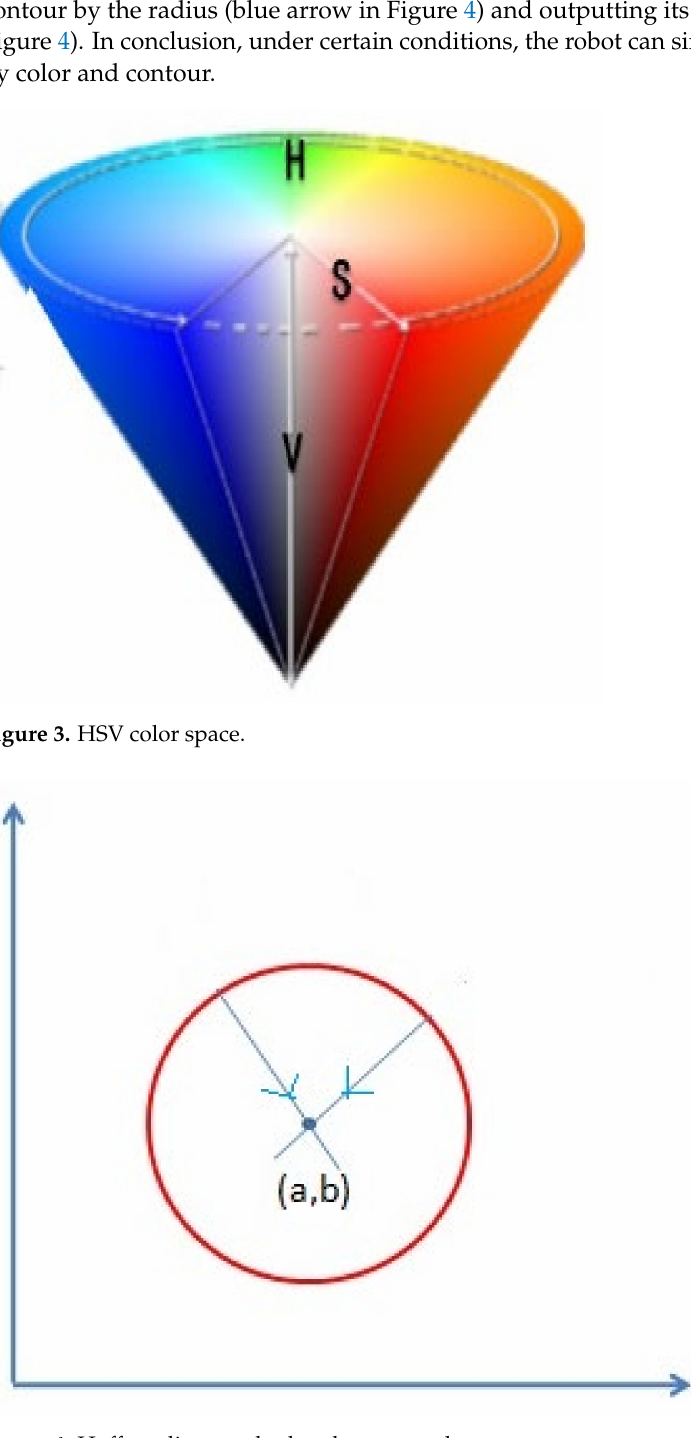
Figure 4. Hoff gradient method to detect